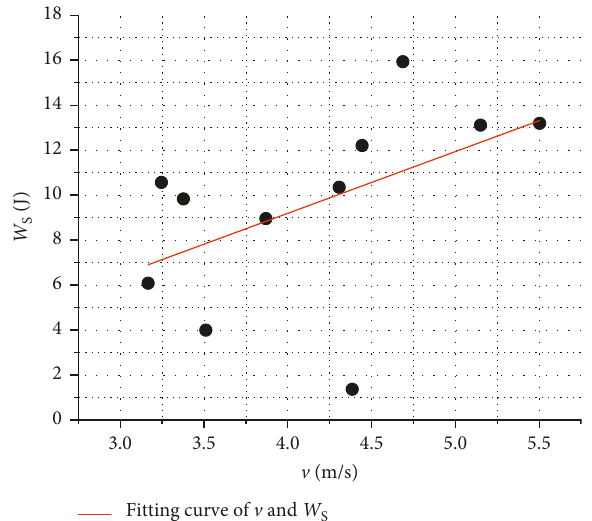
Figure 15: Relationship between v and W